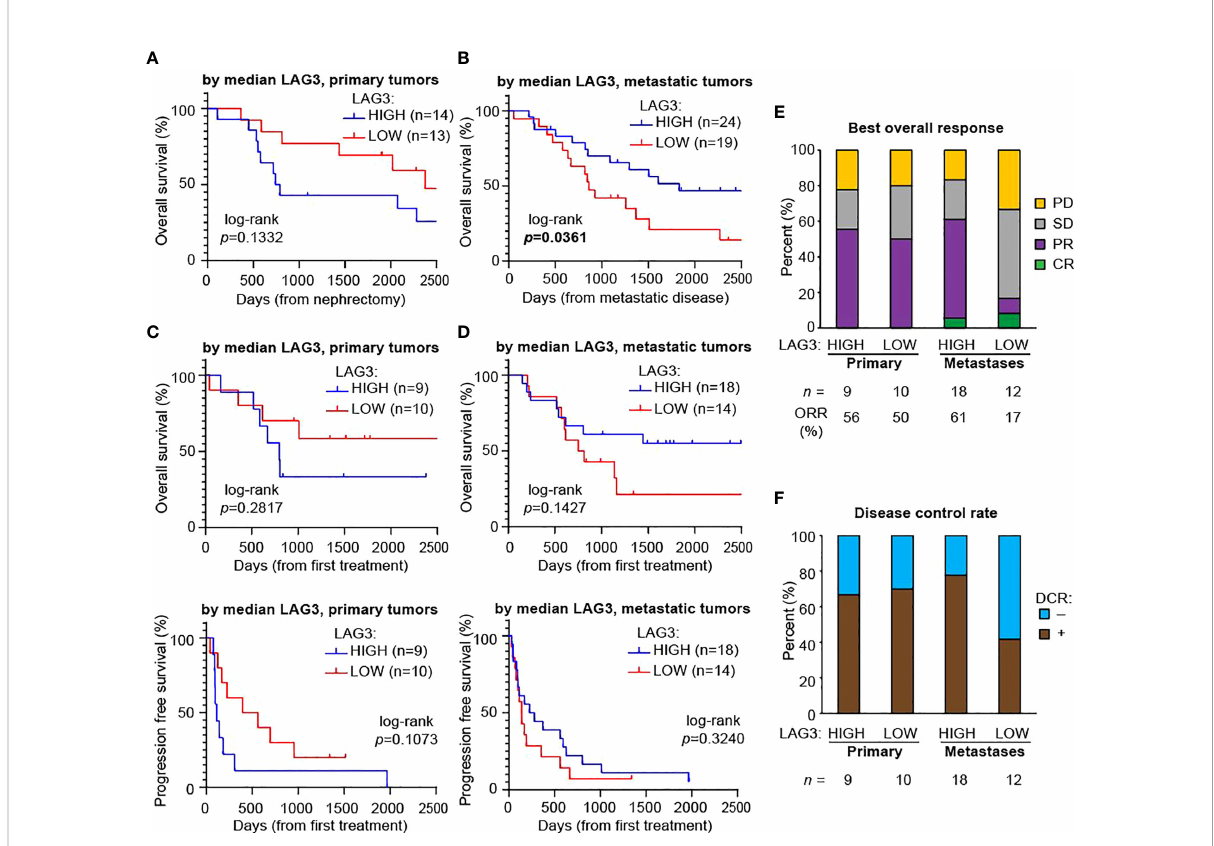
FIGURE 4 Higher LAG3 in metastases is associated with longer overall survival after developing metastatic disease and a higher response rate to immunotherapy. Kaplan-Meier plots of overall survival based on median LAG3 levels in (A) primary tumors after nephrectomy and (B) metastases after developing metastatic disease. Kaplan-Meier plots of overall survival (top panels) and progression-free survival (bottom panels) after the fi rst immunotherapy drug administered based on median LAG3 levels in (C) primary tumors and (D) metastases. All graphs were cut-off at day 2,500 for visualization purposes, with no meaningful changes to the data after this point. Statistical testing was performed with the log-rank test. (E) Best overall responses to immunotherapy. Cohort sizes and the overall response rate (ORR), de fi ned as the proportion of patients with a best overall response of complete or partial response, are displayed beneath the graph. (F) Disease control rates (DCR), de fi ned as the proportion of patients with a best response of complete response, partial response, or stable disease lasting at least six months. Cohort sizes are displayed beneath the graph. CR, complete response; PR, partial response; SD, stable disease; PD, progressive